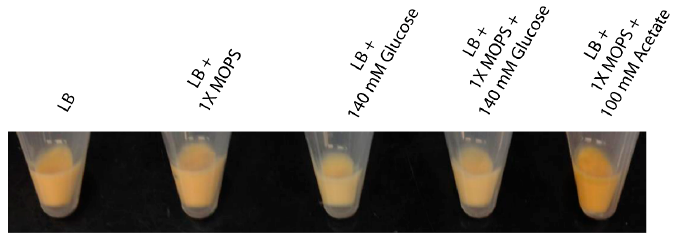
Figure 4. Visible differences in carotenoid content in the Pig1 cells grown in various LB broths. Strain Pig1 was grown for 12 h in LB broths with or without glucose or acetate. The cell pellets were collected and